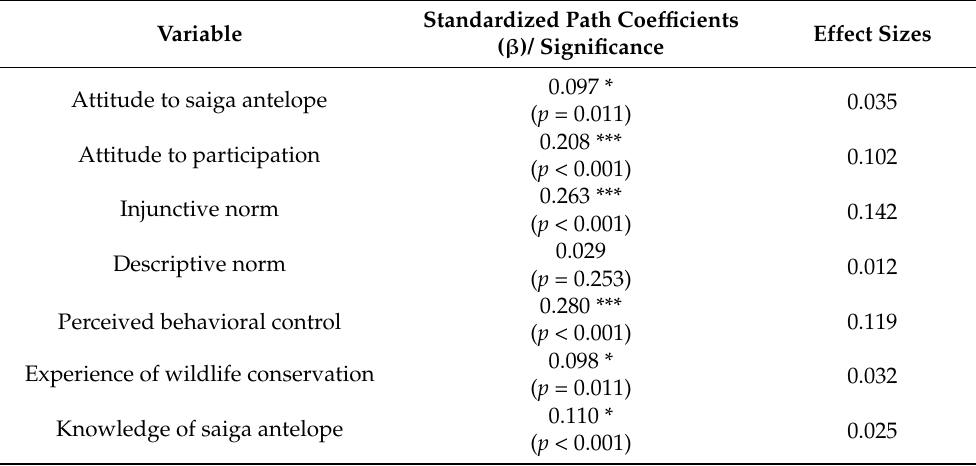
Table 4. Path coefficients and effect sizes, with p -values in